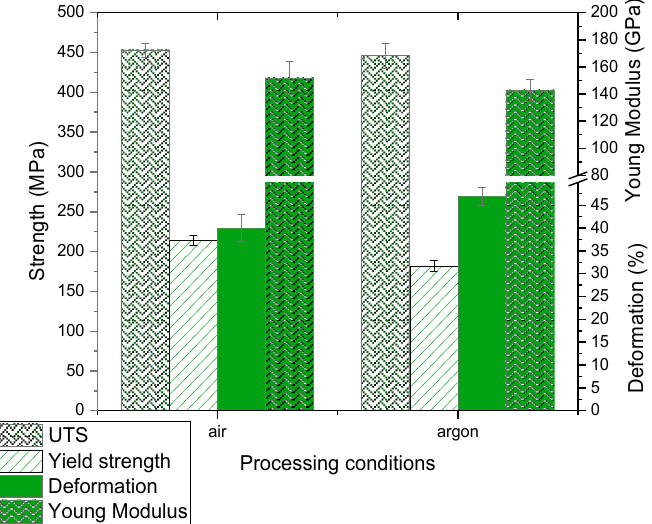
Figure 11. Mechanical properties of PMD specimens after TT1 vs. the processing conditions of air and argon.